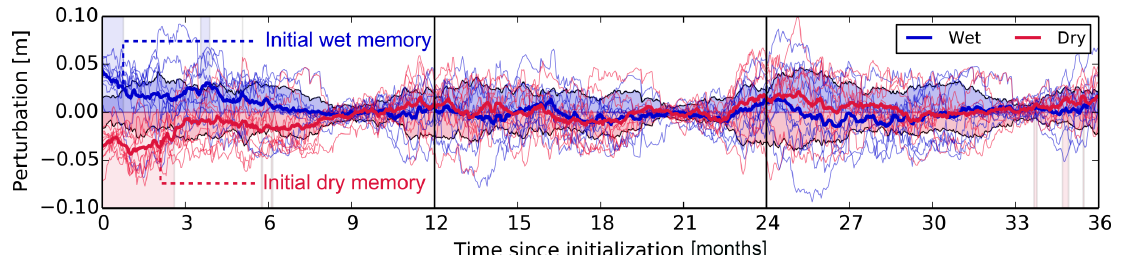
Figure 2. Example for soil moisture perturbation on grid cell scale (June ensemble; grid cell near Hamburg, Germany). The thick blue and red lines indicate the ensemble mean wet and dry perturbation, respectively. The thin lines are single ensemble members and the filled area displays the ensemble standard deviation.